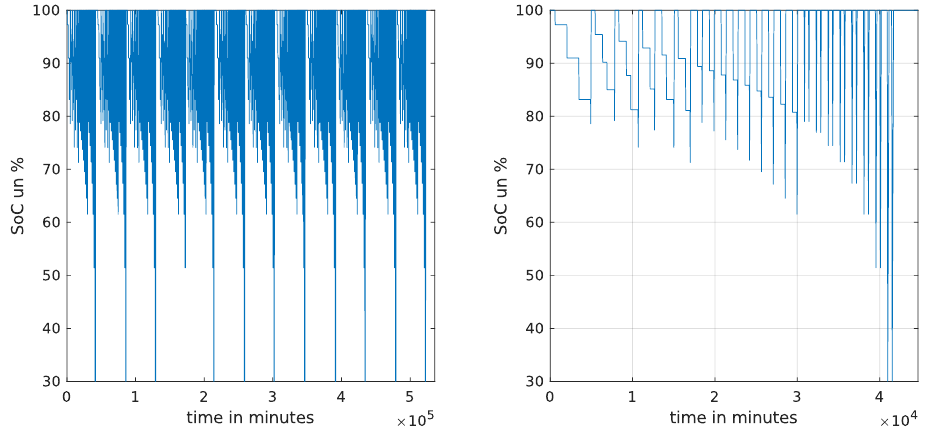
Figure 6. Battery state of charge over a year ( left ) and over a month ( right